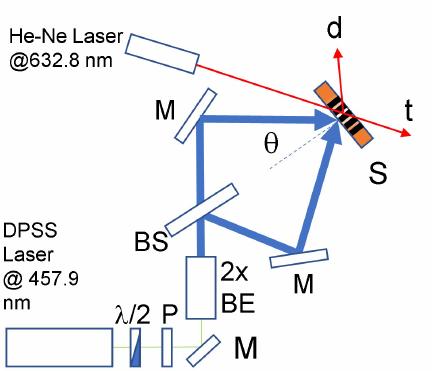
Figure 2. Schematic representation of the writing setup for the high-resolution transmission gratings. l/2 = half wavelength plate; P = polarizer; M = mirror; 2 × BE = 2 × beam expander; BS = beam splitter; S = sample; d and t = diffracted and transmitted beams, respectively. The recorded transmission grating is shown in